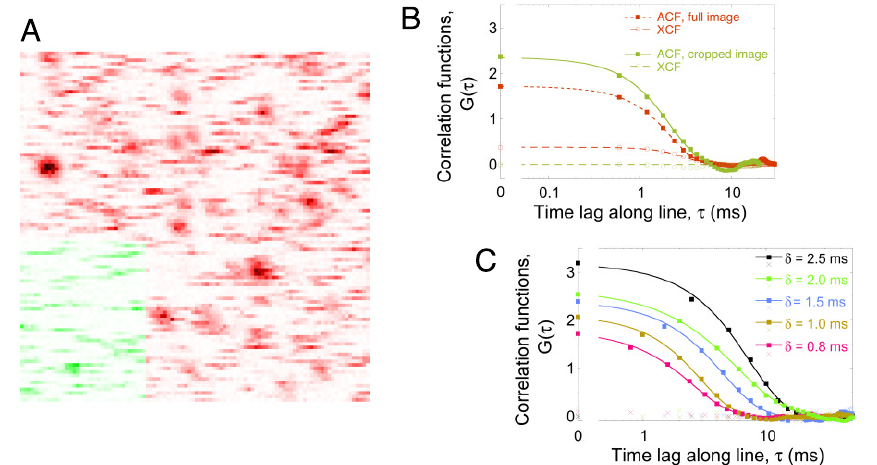
Figure 1. ( A ) Confocal image of a mitochondria-like lipid bilayer containing 0.0025 wt% DiD. Both streaks (corresponding to diffusing DiD molecules) and spots (corresponding to immobile or very slow DiD molecules) can be seen in this image. The image has been inverted for clarity. The highlighted green part seems to contain mostly streaks and was cropped and used for separate analysis. Image size: 10 µm × 10 µm; pixel size: d = 100 nm; pixel dwell time: δ = 0 . 6 ms. ( B ) Average line autocorrelation functions (filled squares) and line cross-correlation functions (empty circles) computed for either the full image (red symbols) or the cropped portion of the image highlighted in green (green symbols) in (A). The data have been fit with Equation (1) (continuous line), Equation (2) (dashed lines) or Equation (3) (dotted line). ( C ) Line autocorrelation functions (filled squares) and line cross-correlation functions (crosses) obtained for different images of the sample shown in (A), imaged at different pixel dwell times and cropped to include only mobile